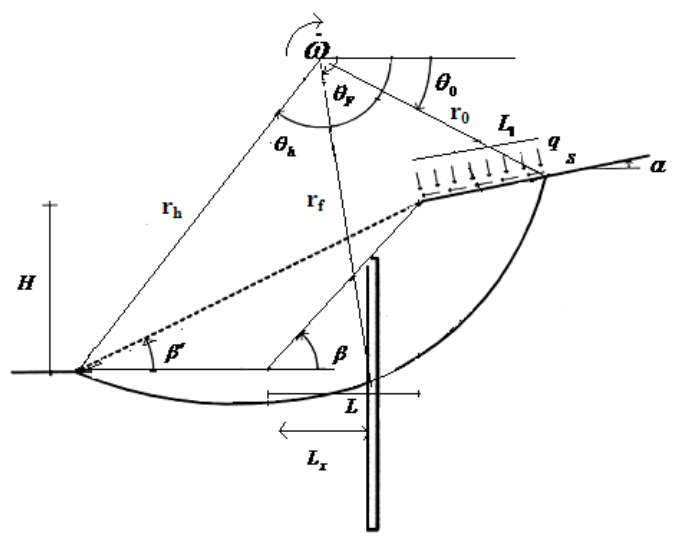
Fig. 4. Slope failure mechanism (Xinpo et al.,